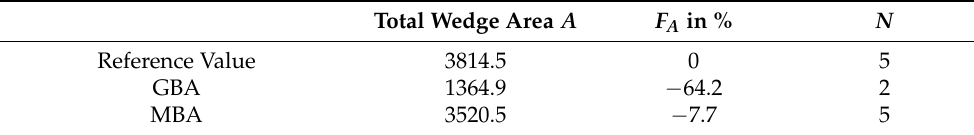
Figure 13. Thermogram of a segment of a rotor blade of an in-service wind turbine with N = 5 turbulence wedges. ( a ) shows the preprocessed thermogram with the turbulence wedges numbered with roman numerals. ( b ) shows the reference transition line, which was estimated manually, as well as the CNR of the wedges noted above the respective wedge. ( c ) shows the result of applying the gradient-based algorithm (GBA) of Gleichauf et al. [14] to the image and ( d ) shows the result of the application of the model-based algorithm (MBA) on the thermogram. Note the reduced color scale. Table 3. Areas determined by the model-based algorithm (MBA) as well as the state-of-the-art, gradient-based algorithm (GBA) for all turbulence wedges in Figure 13. The area values are given in unit pixel 2 and are summed over all turbulence wedges. N is the found or true number of wedges in the